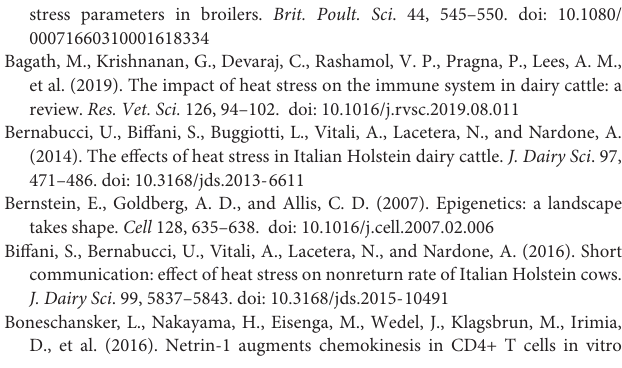
Supplementary Table 1 | Sequencing